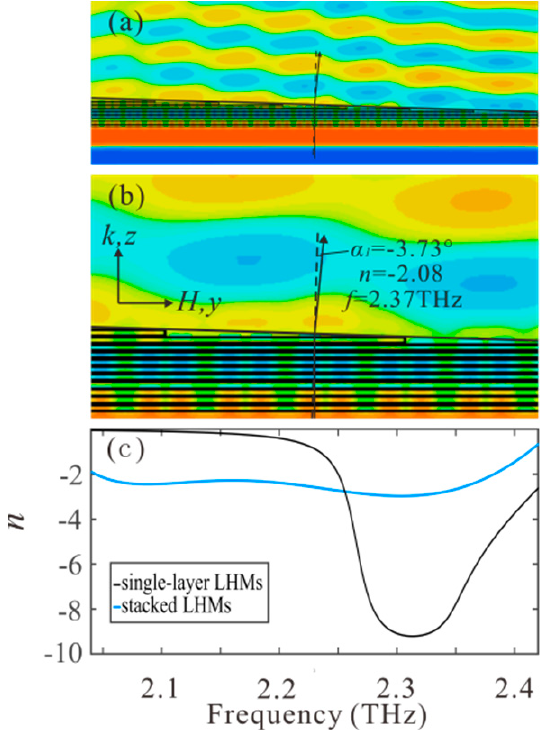
Figure 4. ( a ) E x distribution and ( b ) the local area in a magnified view for a 2.37 THz normal incident wave (the electric field along the x-direction) from the bottom. ( c ) The calculated refractive indices of stacked LHMs (blue line) and single-layer LHMs (black line).